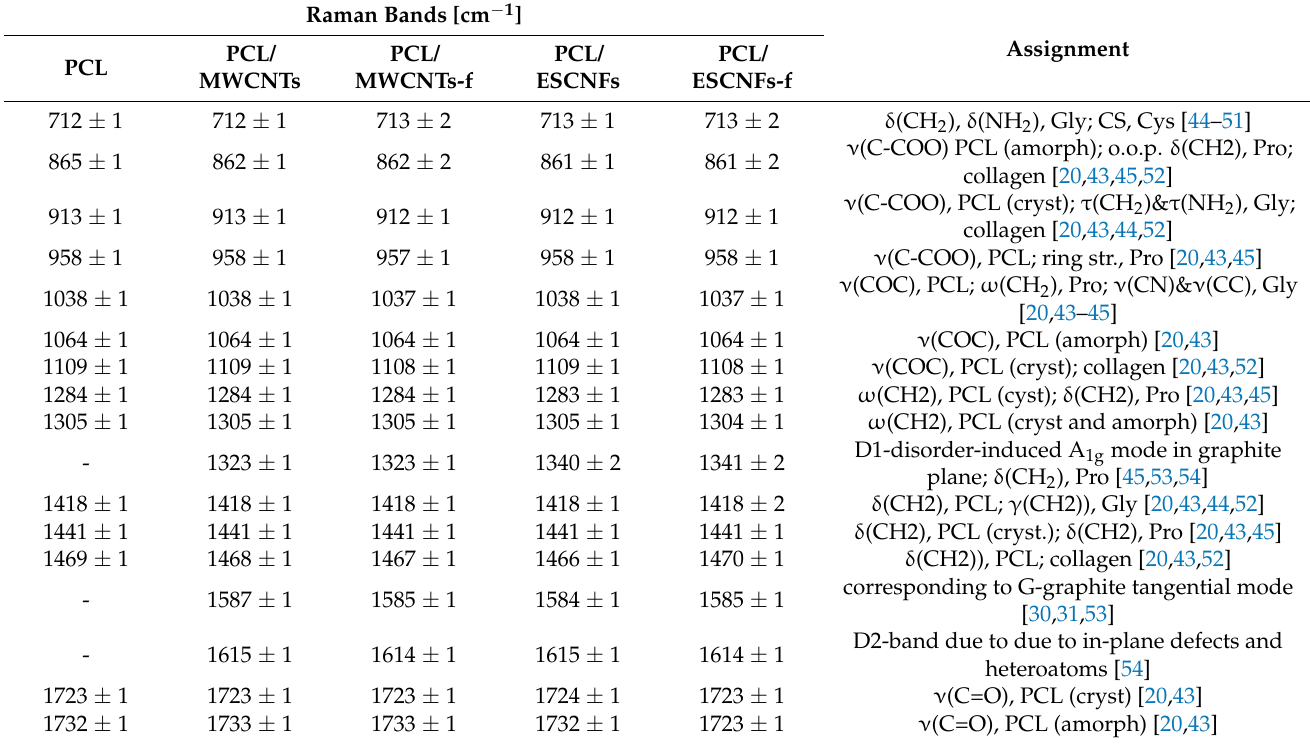
Table 2. Observed characteristic Raman bands [cm − 1 ] and their assignments for PCL, PCL/MWCNTs, PCL/MWCNTs-f and PCL/ESCNFs and PCL/ESCNFs-f nanocomposite membranes in the first day of culture with human U-2 OS cell line, 785 nm laser